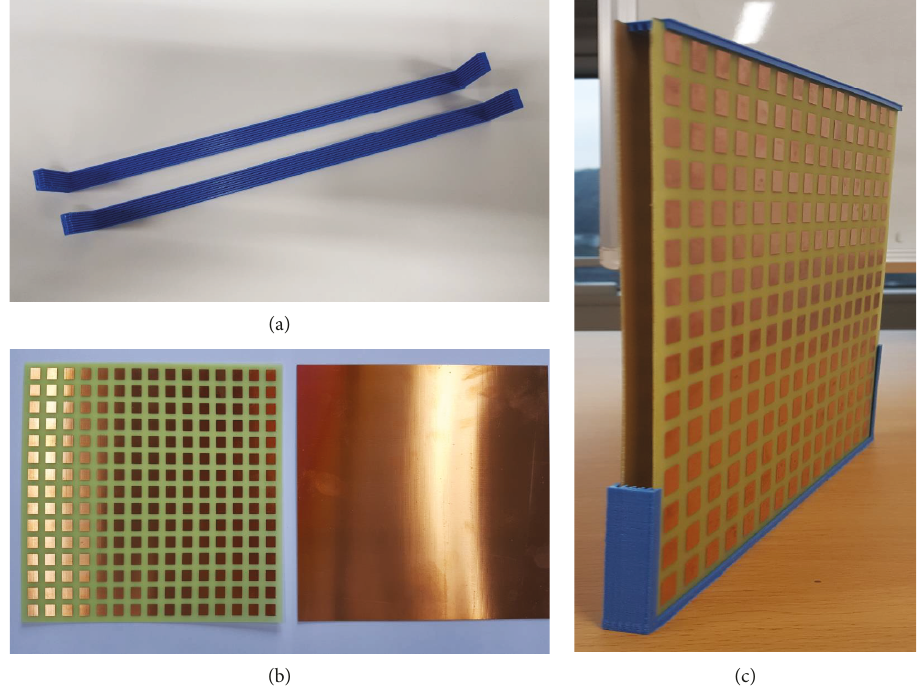
Figure 5: Pictures of the 3D-printed frame for the fi xed air thickness. (a) Fabricated 3D PLA frame. (b) The fabricated absorber. (c) 3D PLA frame with an absorber.